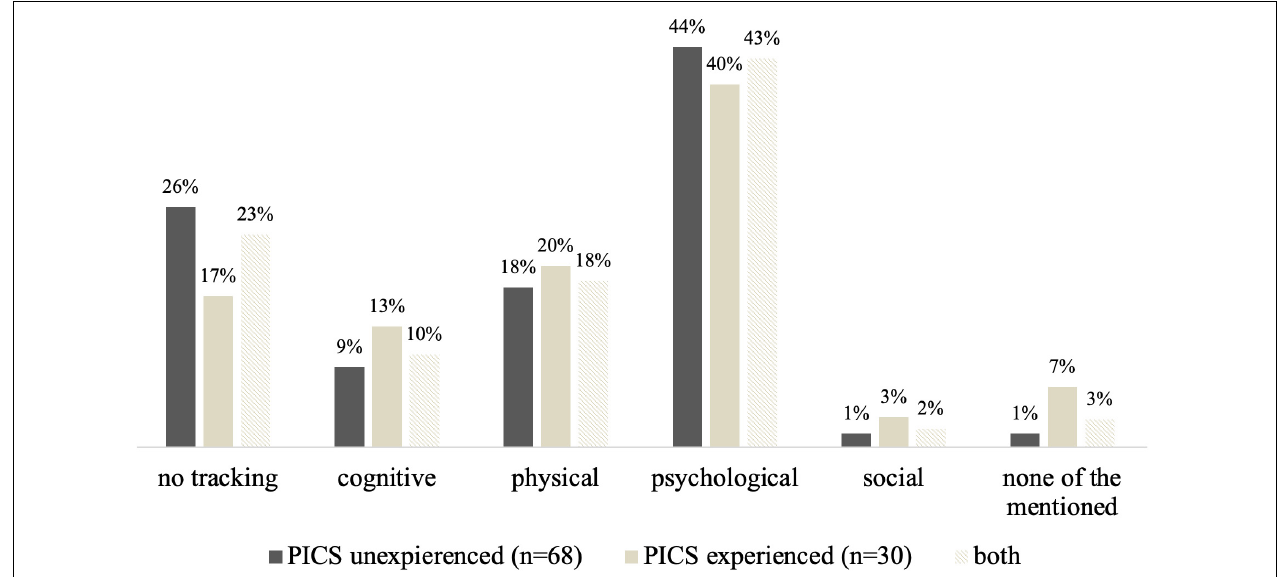
FIGURE 1 | Estimated weighting of long-term consequences after intensive care treatment; n =